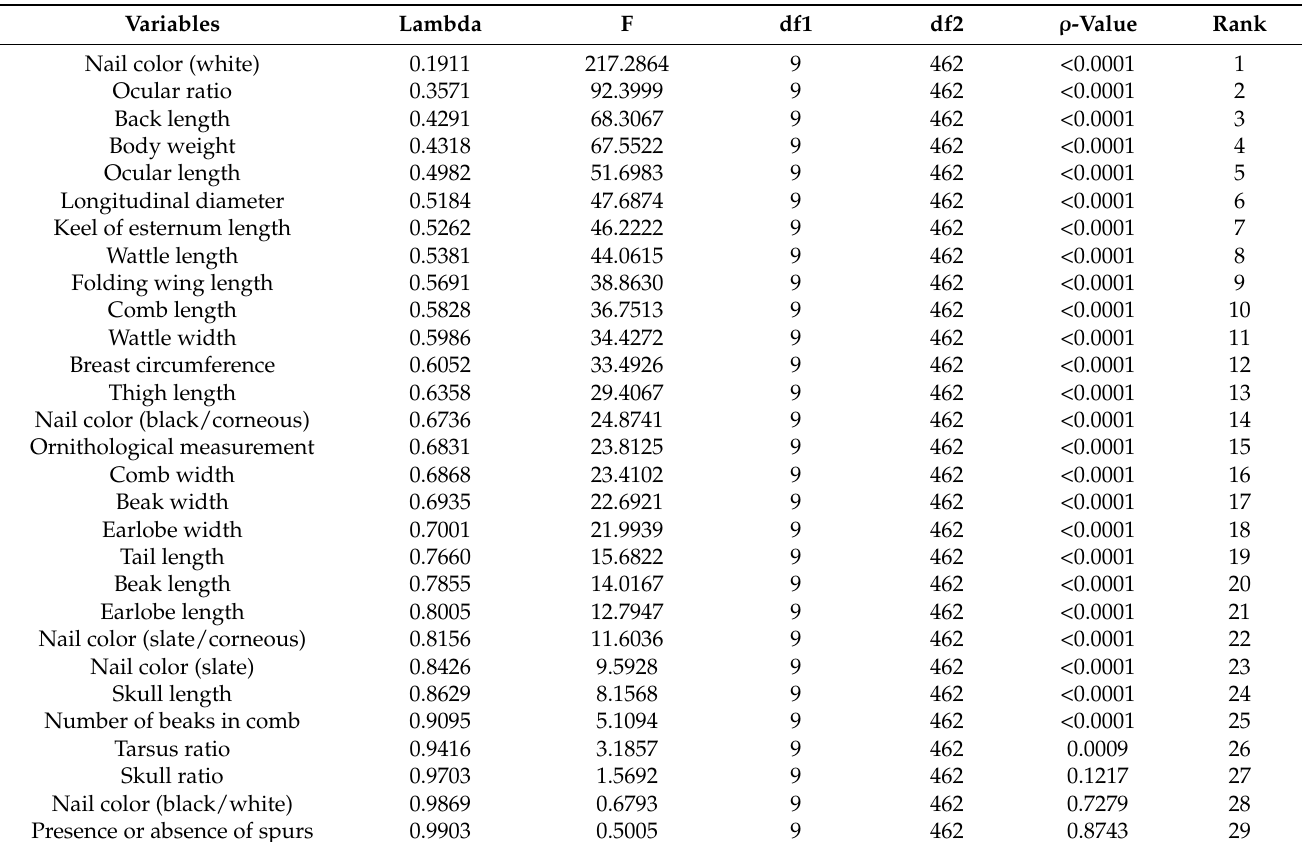
Table 6. Results for the tests of equality of females group means to test for difference in the means across groups once redundant variables were removed in the female